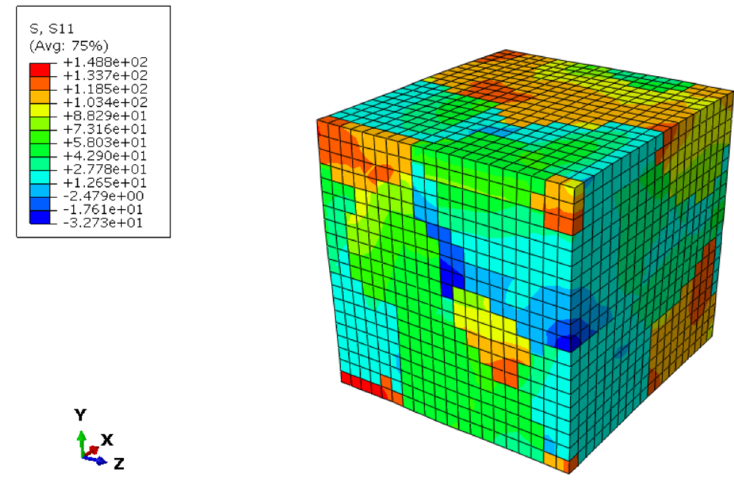
Figure 19. The S11 stress distribution of the polycrystalline RVE under the x-direction tension. Table 6. The test and simulation value of Young’s modulus of standard x-direction static tension. Tensile Specimen Experiment (GPa) Specimen No.